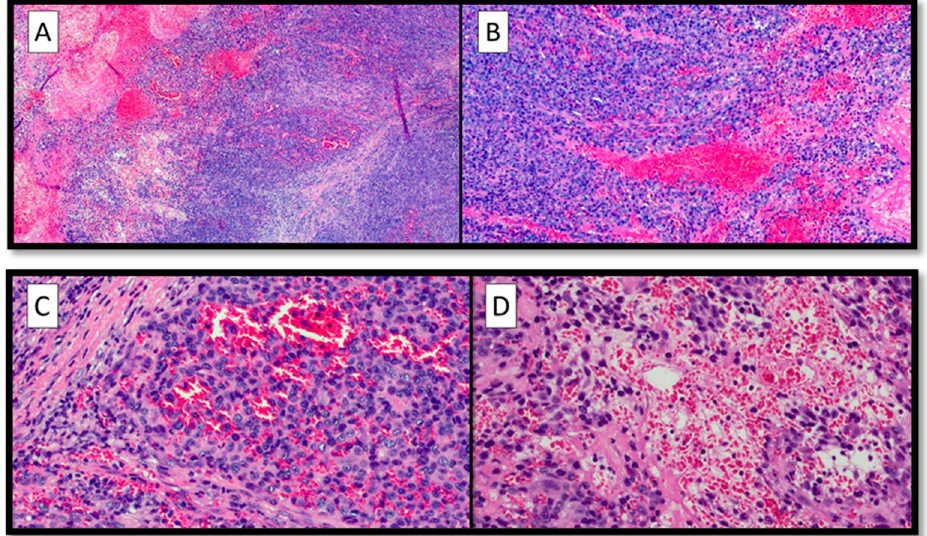
Figure 2. ( A ) Panoramic histopathological view of the lesion examined: note the presence of an abundant pseudo ‐ vascular cell component with extravasated erythrocytes (hematoxylin–eosin, original magnification 4×). ( B ) Histological preparation showing cytological details of the neoplastic cells: pleomorphic, atypical elements, with pseudo ‐ vascular appearance (hematoxylin–eosin, original magnification 10×). ( C ) Photomicrographs showing pseudo ‐ vascular structures containing red blood cells, with some foci of necrosis (H&E, original magnification 20×). ( D ) Details of the previous picture showing foci of hemorrhage (H&E, original magnification 20×).